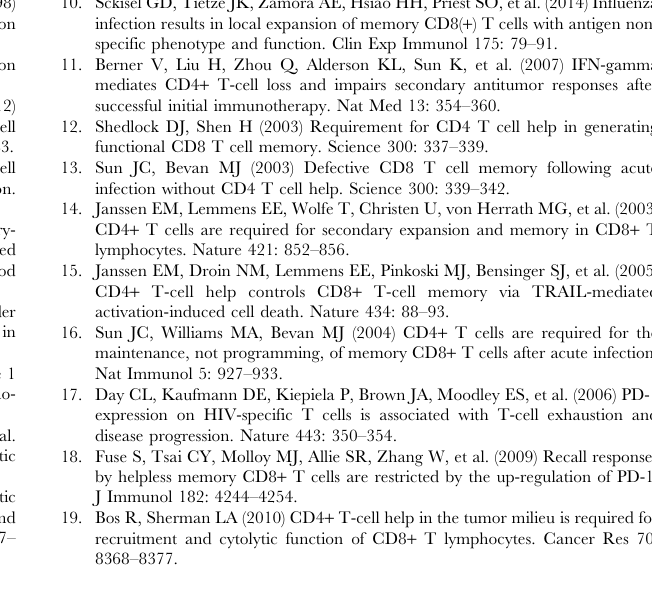
Figure S3 IT induced function and expansion of by- stander memory CD8 + Tcells does not require IL-21 signaling. Wild-type or IL-21 RKO were treated with IT or PBS/rIgG (control) and harvested at Day 11 after the initiation of therapy. CD8 + T cell and memory CD8 + T cell expansion, and analysis. Total number of splenic CD8 + T cells ( a ) and memory splenic memory CD8 + T cells. Results are representative of three independent experiments with three mice per group. (* P ,